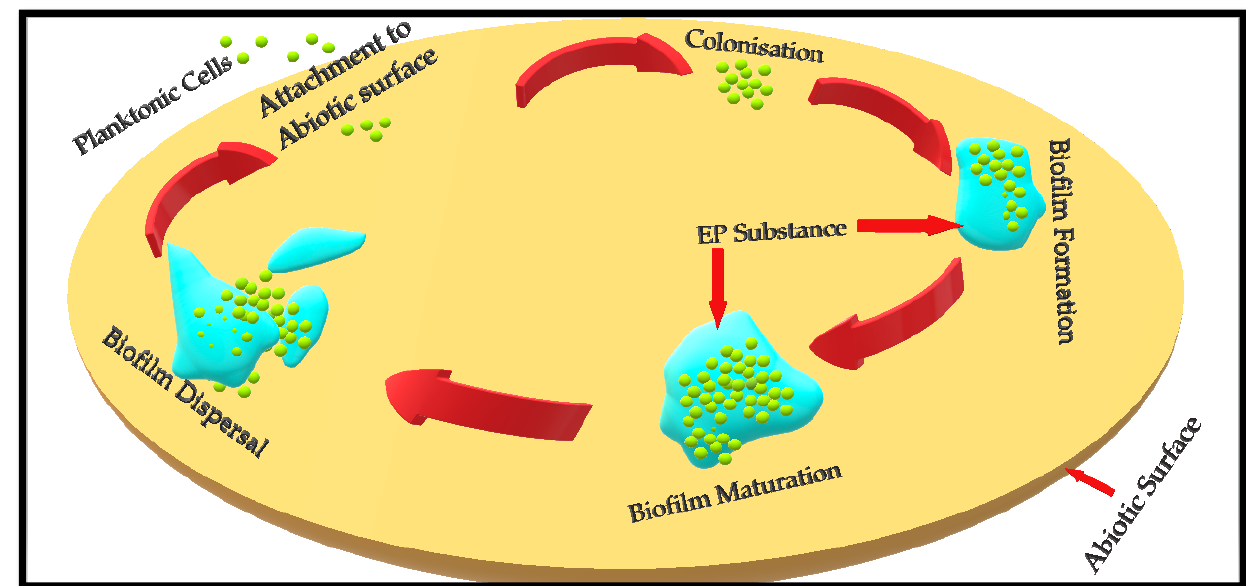
Figure 1. Depiction of Staphylococcus aureus biofilm formation on an abiotic surface. Basic concept has been adopted from Idrees et al. (2020) and Paharik (2016) [7,26].